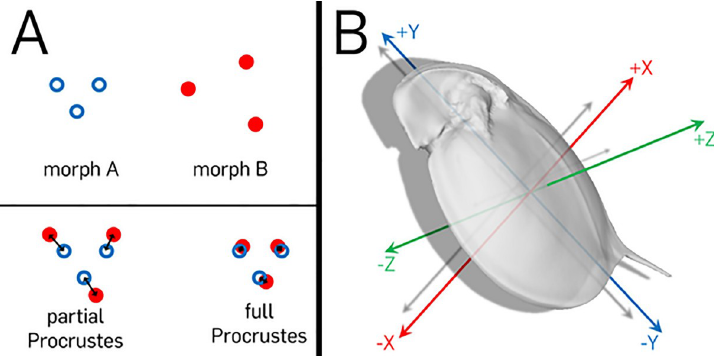
Fig 1. Procrustes distance and axes definition. (A) For Procrustes analysis, two landmark-sets, morph A and morph B, with an equal number of vertices (points) are required. Procrustes analysis allows to bring these two landmark sets in the best overlapping fit without changing their relative positions, using at least pan and rotation. This is called partial Procrustes fit and allows comparisons of form. If in addition to pan and rotation also scaling is adjusted, the result is a full Procrustes fit and allows shape analysis. Double-headed arrows give point-wise Procrustes distances, which are minimized during the analysis. The average Procrustes distance is the mean length of all arrows. Landmark- sets that differ only in scaling would overlap perfectly using full Procrustes, leading to a Procrustes distance of zero. (B) For the analysis of alterations, daphnids are inspected direction-wise: The dorso-ventral body axis is represented by the x-axis, with positive values towards the dorsal end. The longitudinal body axis is represented by the y-axis, with positive values towards the head. The lateral body axis is represented by the z-axis, with positive values out of the drawing plane, towards the viewer.